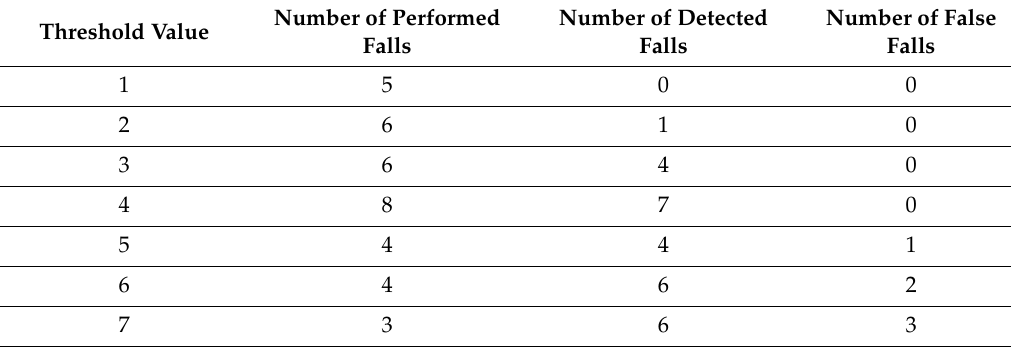
Table 7. Comparison between the number of falls performed by the user and number detected by MMA8452Q sensor for di ff erent threshold values; the last column reports false falls (not occurred) detected by the